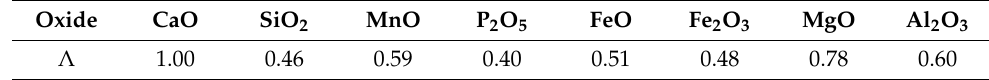
Table 6. Optical basicities of different